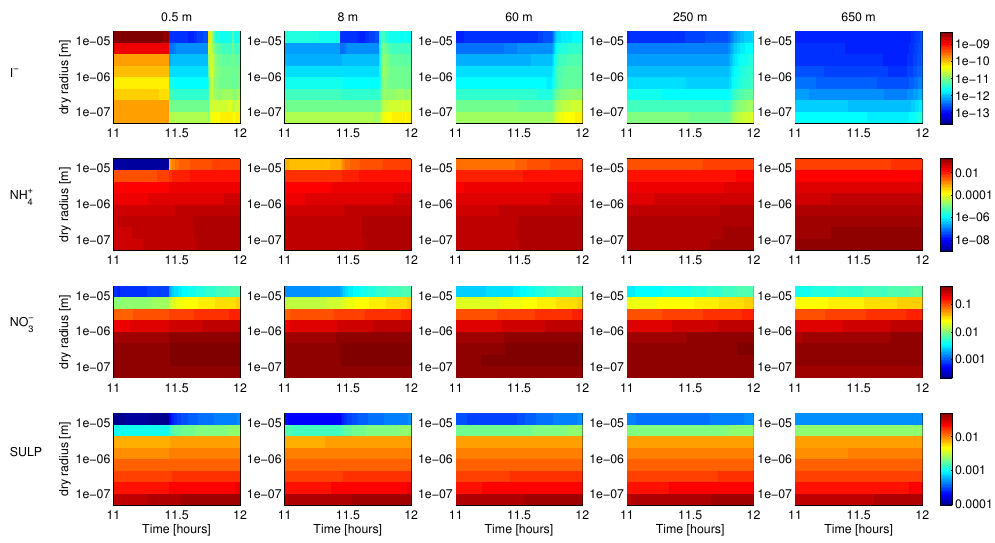
Fig. 6. Seasalt compositional data at different levels through the model column for the base case, low tide, model run. First, second and third rows are I − , NH + and NO − dry mole fractions, respectively. The fourth row is the summed dry mole fraction of H 2 SO 4 ( aq ) , HSO − 4 3 SO 2 − 4